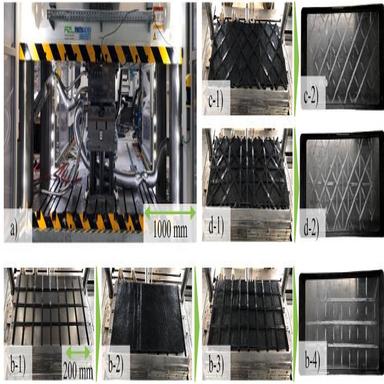
Illustration of a hydraulic press (a); manufacturing process of 0/90 towpreg reinforced SMC (placing first ply 0/90 towpreg, SMC plies and second ply 0/90 towpreg on the mould and the resulted part (b-1 - b-4)); close-up of +45/− 45 (c-1) and +45/− 45/90/0 (d-1) towpreg on the mould and the corresponding final parts (c-2 and d-2).